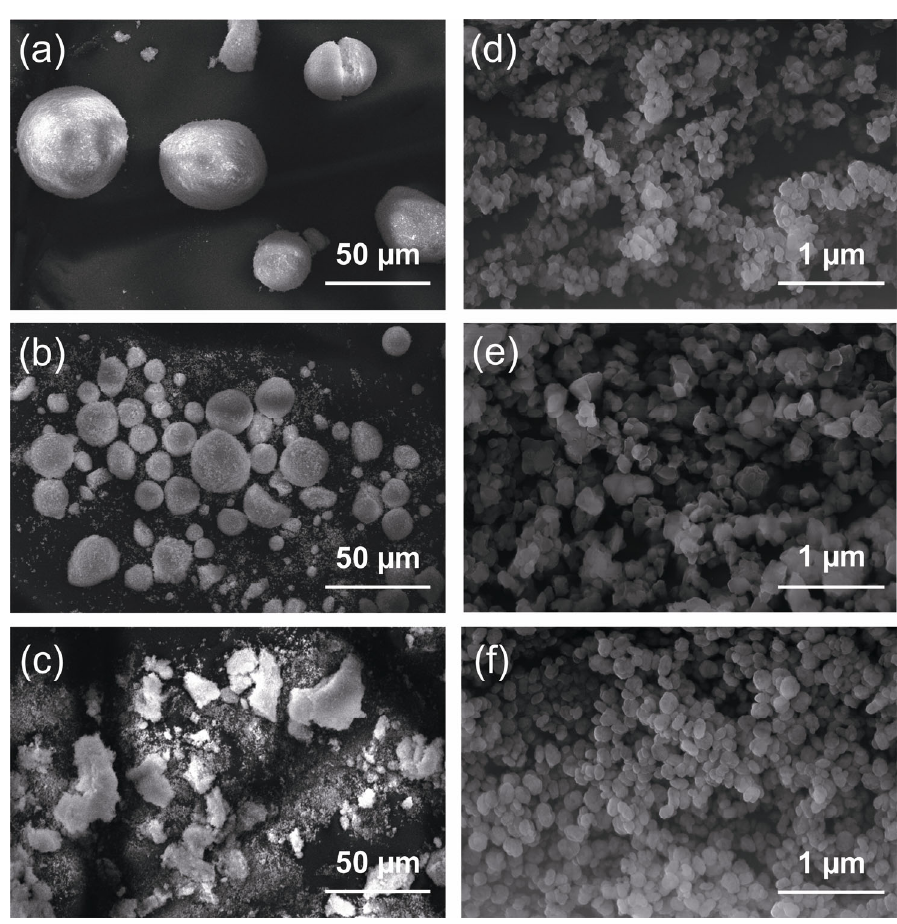
Fig. 1 SEM images of the YSZ powders: (a, d) TZ-8Y; (b, e) MELox 8Y; (c, f) YSZ-HT. The images (a–c) show the as-received form and (d–f) show the primary particles.